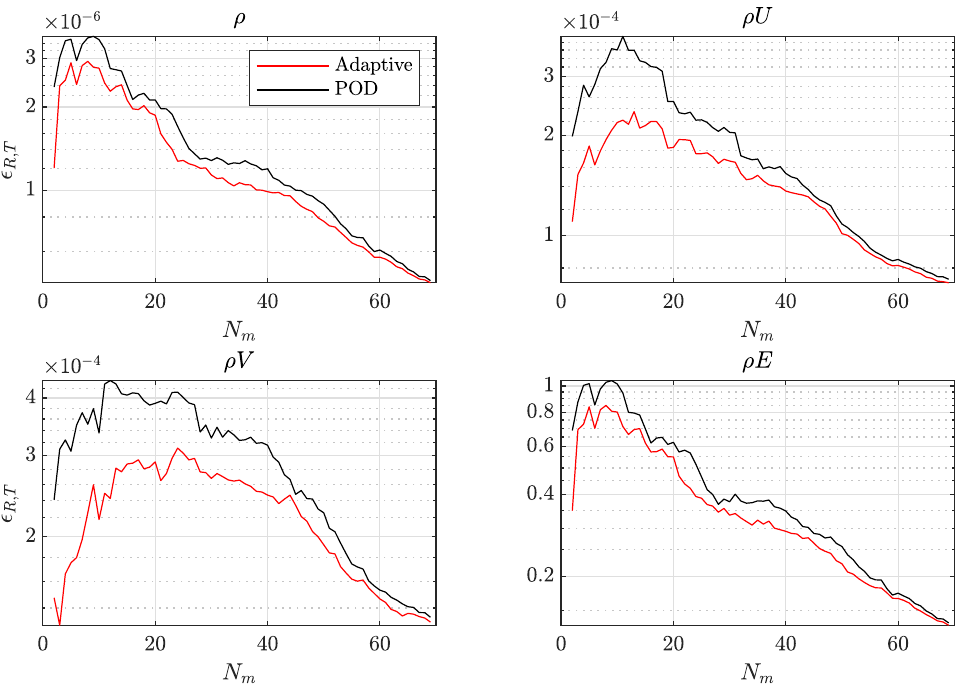
Figure 2. The log 10 ( (cid:101) R,T ) varying the number of modes, for adaptive ROM and POD, NACA0009 test